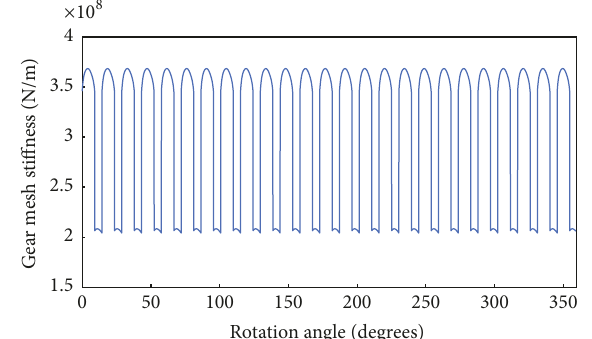
Figure 13: Gear mesh stiffness between a set of two healthy gears.